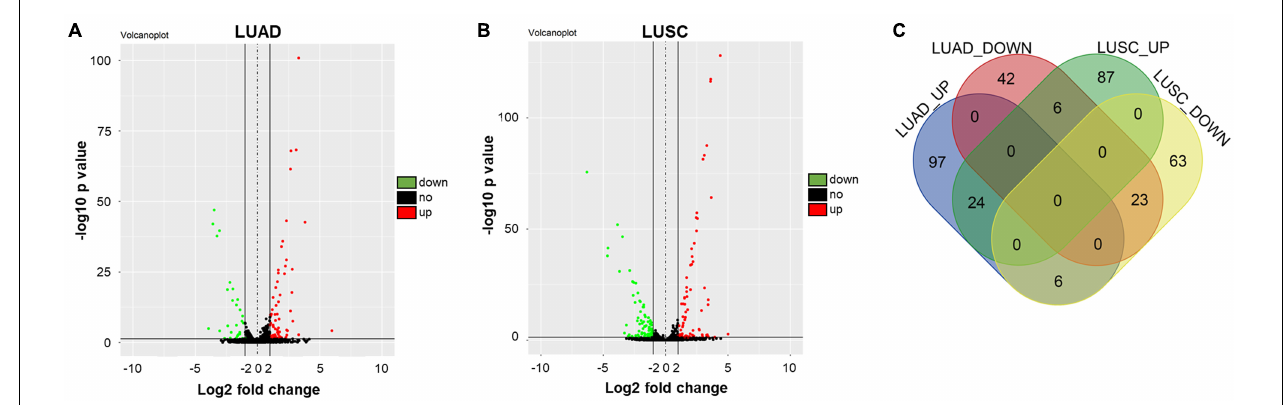
FIGURE 1 | Differentially expressed miRNAs in NSCLC. (A,B) Volcano plots illustrating the miRNAs differentially expressed in NSCLC detected in the TCGA dataset. Red indicates a higher expression level, while blue indicates a lower expression level. (C) Venn diagram showing the overlap among the differentially expressed miRNAs in TCGA dataset. Among these differentially expressed miRNAs in TCGA, 23 were commonly downregulated, whereas 24 were commonly upregulated.